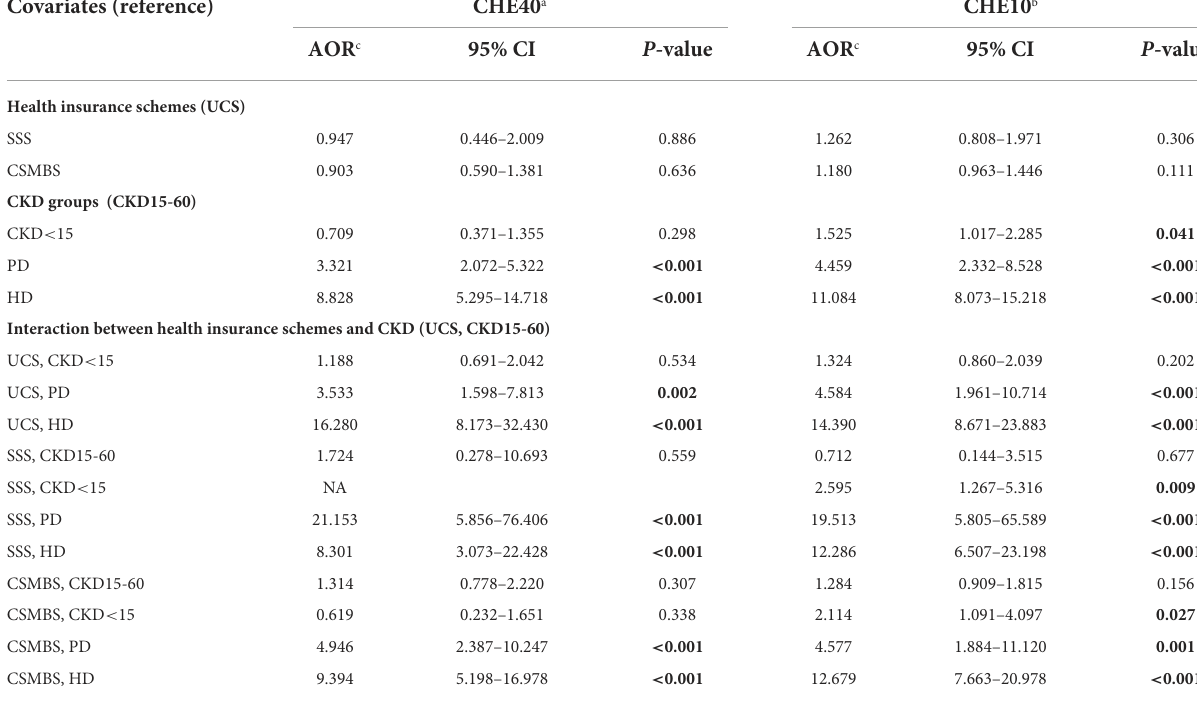
TABLE 3 Multivariable analysis of health insurance schemes and CKD groups on CHE. Covariates (reference) CHE40 a CHE10 b AOR c 95% CI P -value AOR c 95% CI P